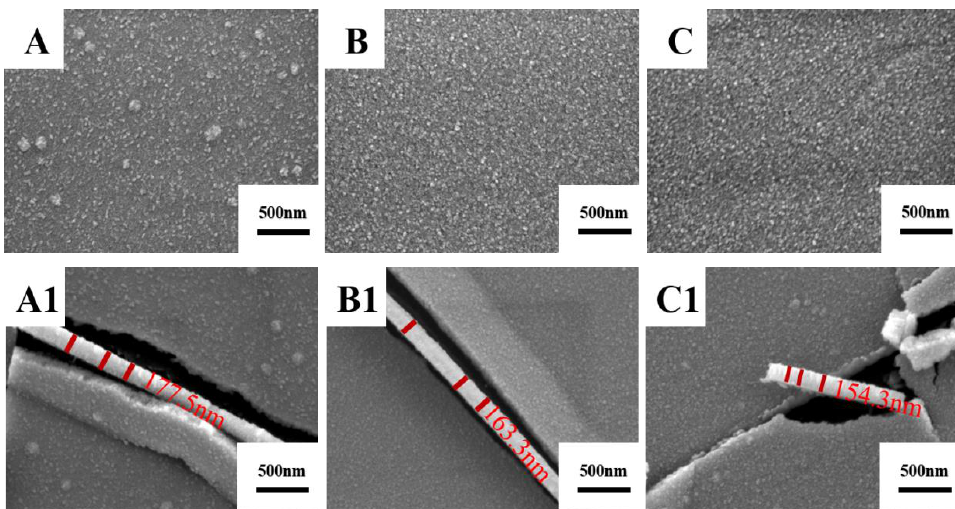
Figure 9. Surface and cross-sectional morphologies of films prepared by three high-purity Ti targets. ( A ) Surface morphology of film prepared by target C1; ( B ) Surface morphology of film prepared by target C; ( C ) Surface morphology of film prepared by target C2; ( A1 ) Cross-sectional morphologies of film prepared by target C1; ( B1 ) Cross-sectional morphologies of film prepared by target C. ( C1 ) Cross-sectional morphologies of film prepared by target